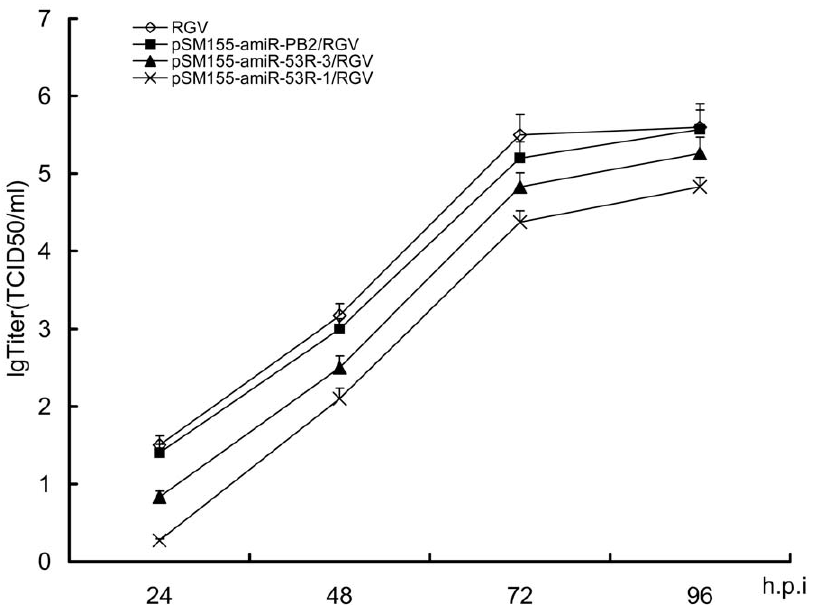
Figure 3. Comparison of virus titers. GCO cells that transfected with pSM155-amiR-53R-1, pSM155-amiR-53R-3 and pSM155-amiR-PB2, respectively, were infected with RGV at 24 h post transfection (MOI of 3). Cell supernatants were collected at 24, 48, 72 and 96 h.p.i. and assayed for virus titration. The titers of RGV in pSM-amiR-53R-1 transfected samples were about 17 -fold, 12-fold, 14-fold and 6-fold lower than those of the transfected with pSM155-amiR-PB2 at different time intervals, respectively. The data show the average titers of three independent experiments in lgTCID 50 plus S.D.